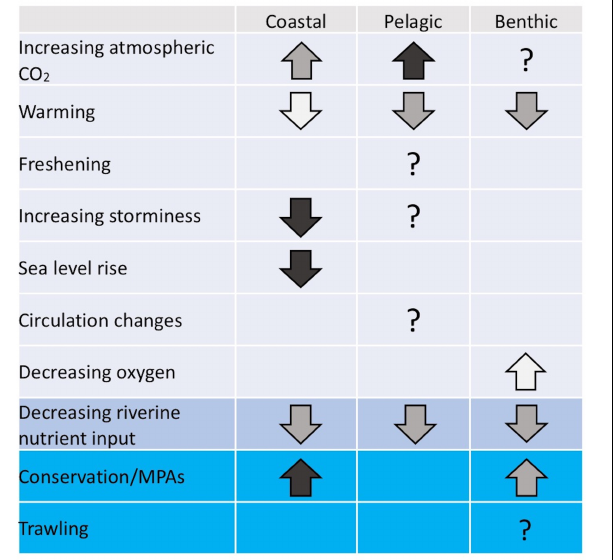
FIGURE 6 | The expected impact of key future changes on coastal, pelagic and benthic carbon stocks, considered in isolation to each other. Arrow direction indicates whether the stock in question is expected to increase or decrease given the influence on the left, and the color of the arrow represents the confidence we have in this expected change, with white, gray and black representing low, medium and high confidence, respectively. Question marks indicate that the stock is expected to change but the overall direction of the change is unknown. Influences which are directly manageable within the study region are shaded in blue. Only the 6 most important or potentially important influences (in the view of these authors) are considered for each system (benthic, pelagic and